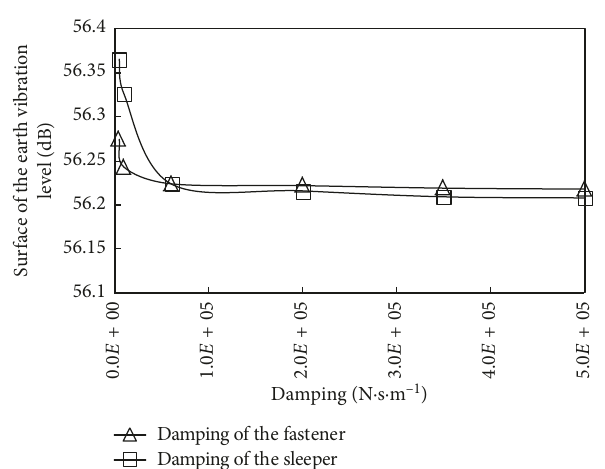
Figure 19: The influence of damping change on the vibration power